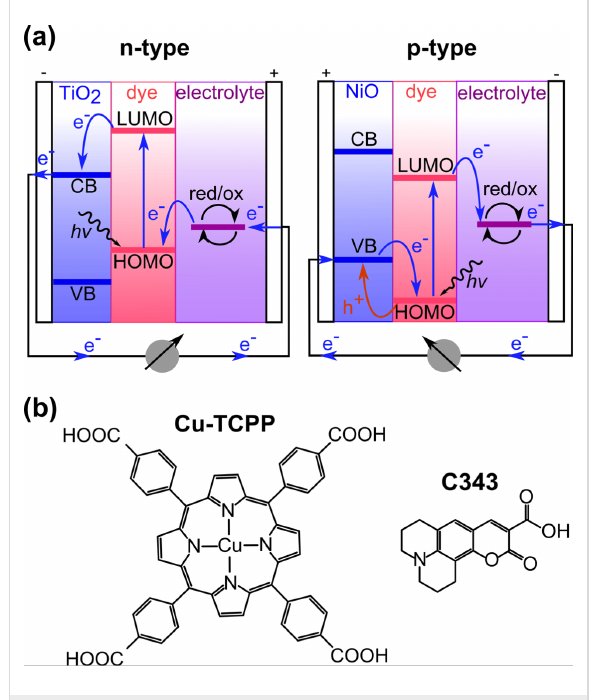
Figure 1: (a) Principle of n- and p-type DSSCs showing opposite charge transfer directions. (b) Structures of Cu-TCPP and C343.